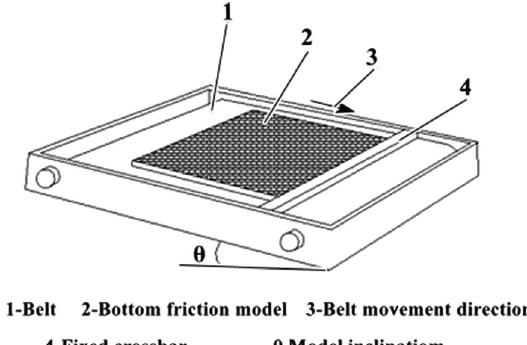
Fig. 10 Bottom friction test